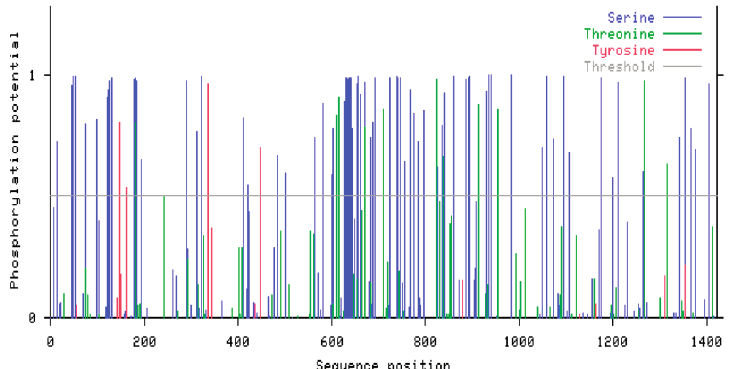
Figure 6. Predicted phosphorylation sites in Edc4 protein sequence: In silico Edc4 protein sequence analysis revealed Edc4 as a highly phosphorylated protein. A total of 86 serine, 11 threonine and 4 tyrosine phosphorylation sites were predicted in the Edc4 protein sequence where blue, green and red spectral lines represent serine, threonine and tyrosine respectively. There are 16 consecutive serine phosphorylation sites near the 600 amino acid sequence position of Edc4.